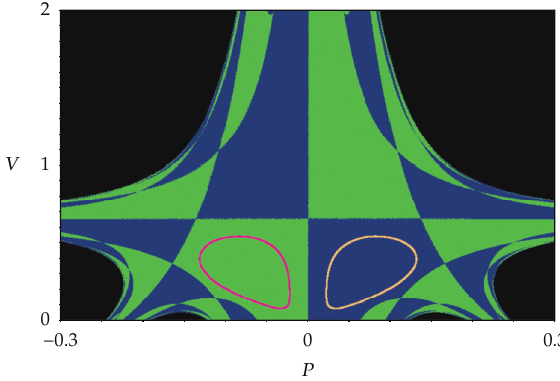
Figure 2: Phase diagram illustrating attractor basins for symmetric limit cycles (cid:3) N (cid:8) 2 . 9 (cid:4)